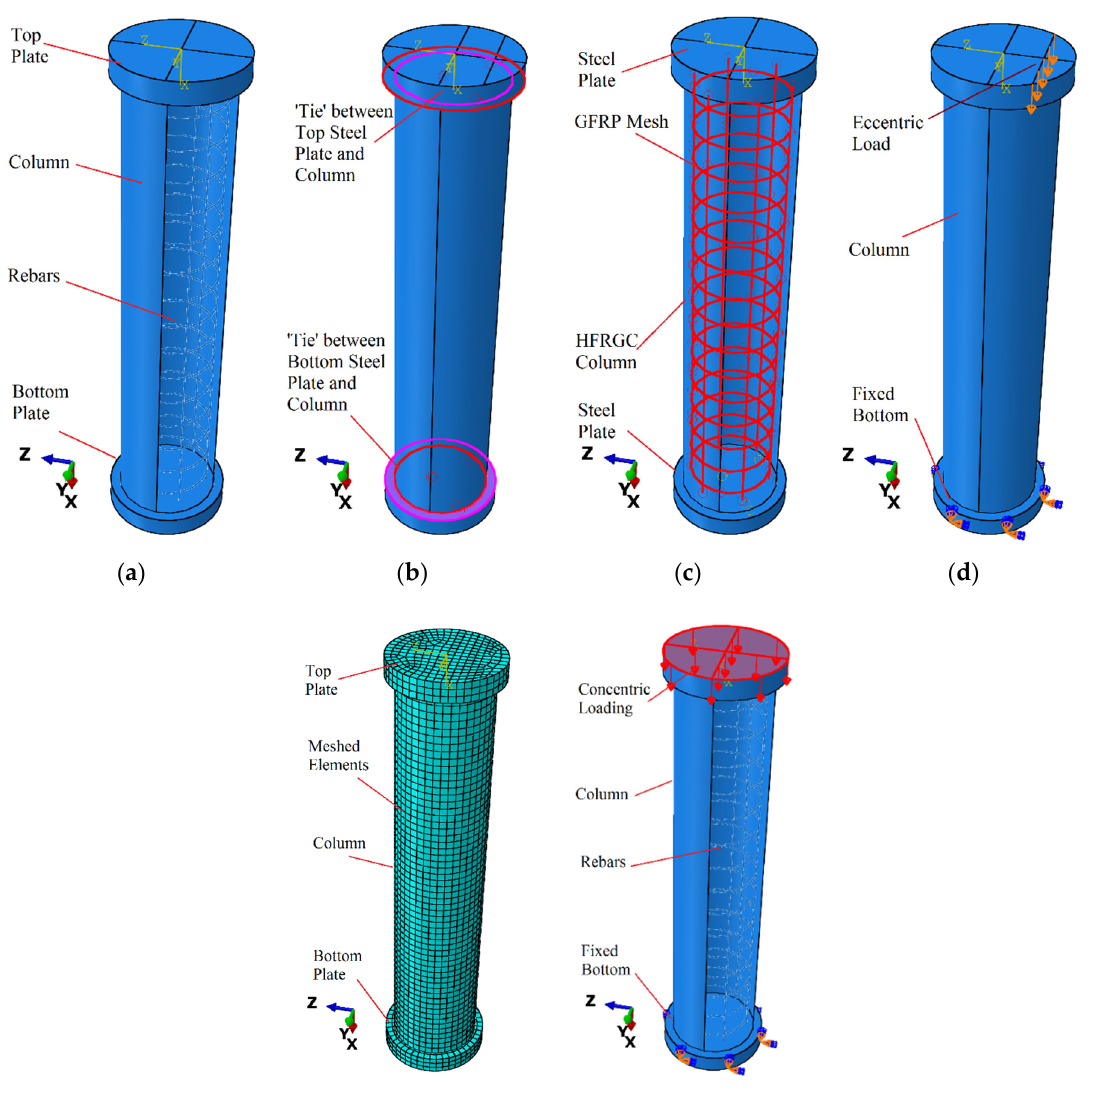
Figure 4. Simulated control model ( a ) geometry ( b ) interaction between steel plates and column ( c ) ‘embedded region’ between reinforcement and HFRGC ( d ) eccentric loading ( e ) meshed elements ( f ) concentric loading.